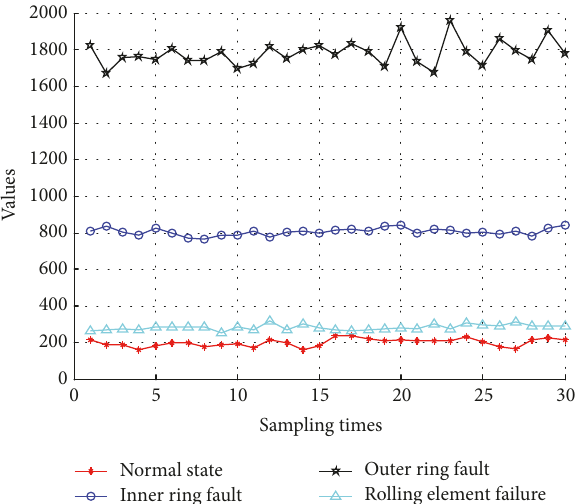
Figure 12: Frequency domain index (Hilbert envelope singular value) under four cases.